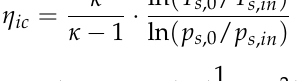
Figure 4. Computational grids for different components of the computational fluid dynamics (CFD) models. Considering that different turbulence models have specific requirements for the dis- tance from the first node of the grid to the solid wall, the y + values obtained with the above computational grids were checked in Figure 5. It can be found that the y + values of over 90% for the solid surfaces were in the range of 1–8, and the maximum y + value was less than 10, which met the requirement of the Spalart–Allmaras turbulence model employed in this paper. In addition, the qualities of the computational grids are provided in Table 3, proving that good grid quality was achieved for the present numerical solu- tions. ( a ) Radial inlet chamber ( b ) Compressor stage Figure 5. y + distributions of the computational grids .